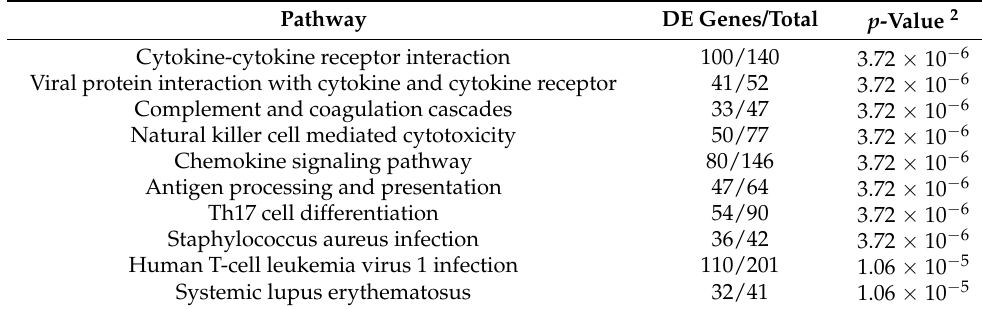
Table 3. Top 10 pathways overrepresented in WT lacrimal glands 1